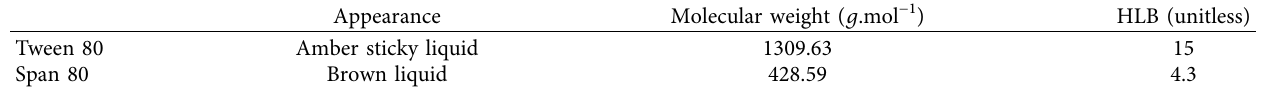
Table 3: Physical properties of Cetyl Trimethyl Ammonium Bromide (CTAB).